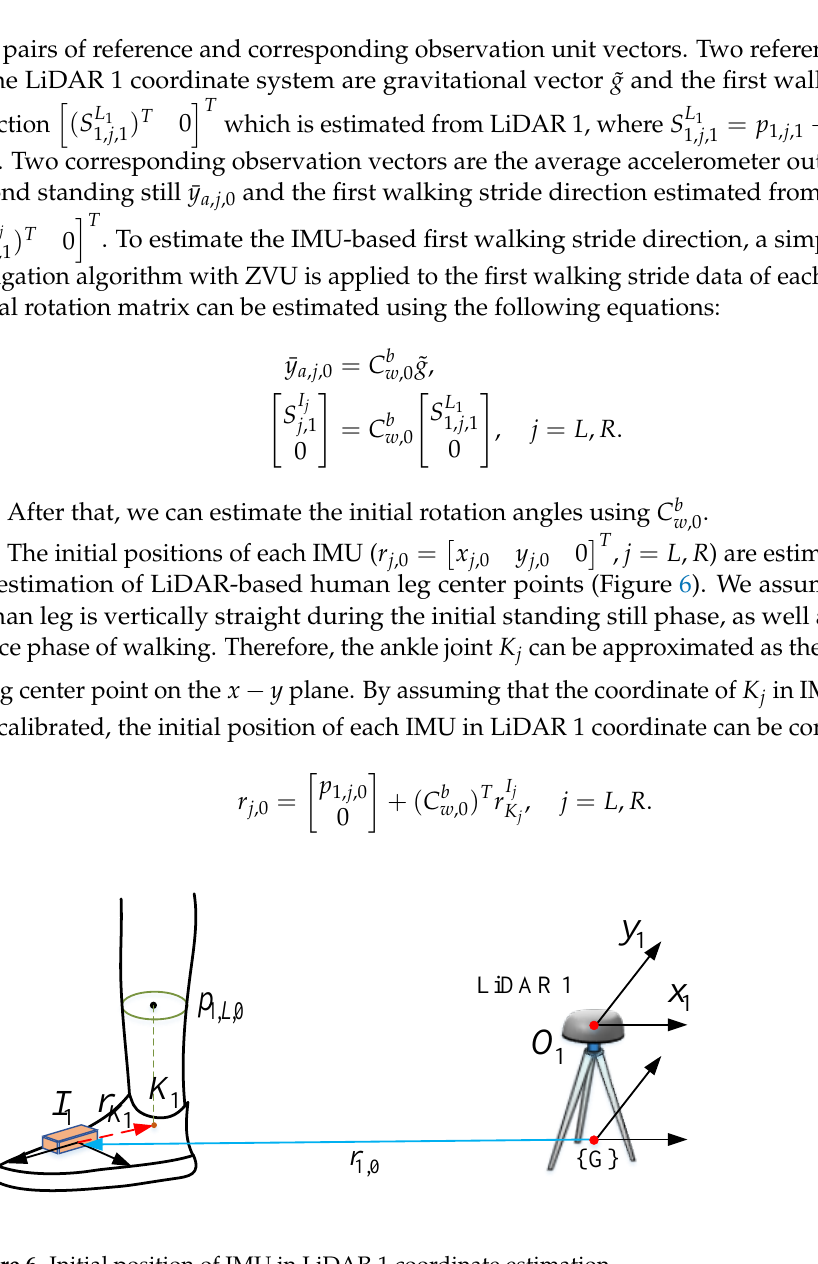
Figure 6. Initial position of IMU in LiDAR 1 coordinate